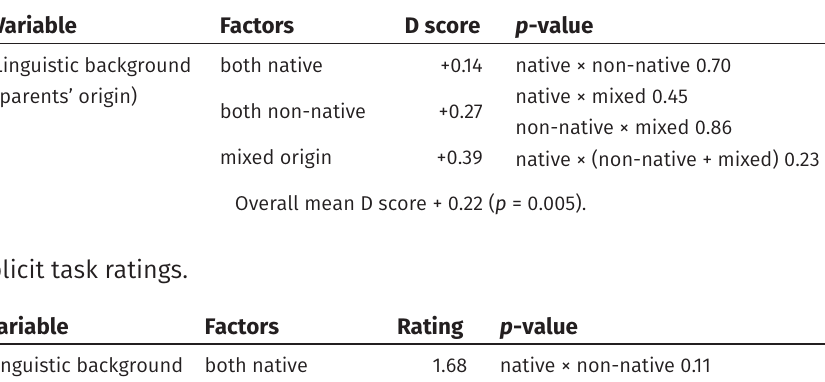
Table 3: D Scores (Implicit Association Test).